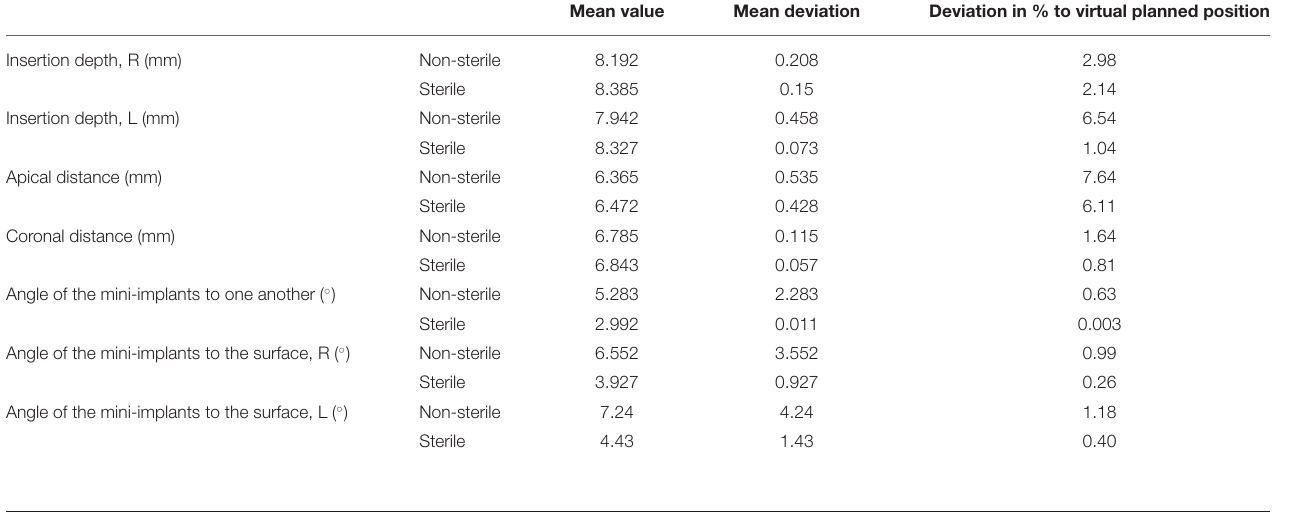
TABLE 1 | Results of the analysis of post insertion position of the mini-implants and deviation in % to the virtually planned position. Mean value Mean deviation Deviation in % to virtual planned position